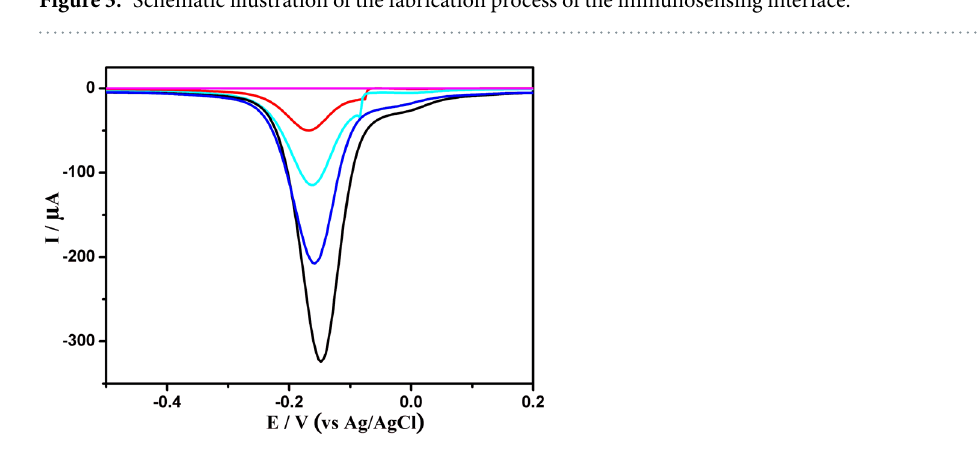
Figure 4. SWV responses of the modified procedure of electrodes in 0.1 M PBS and 5 mM H 2 O 2 (pH 7.0). ( a ) bare GCE; ( b ) poly(thionine)-Au nanocomposite modified GCE; ( c ) anti-CYFRA21-1/poly(thionine)-Au nanocomposite modified GCE; ( d ) blocked with 1% BSA; ( e ) modified glassy carbon electrode after incubation with 0.5 ng mL − 1